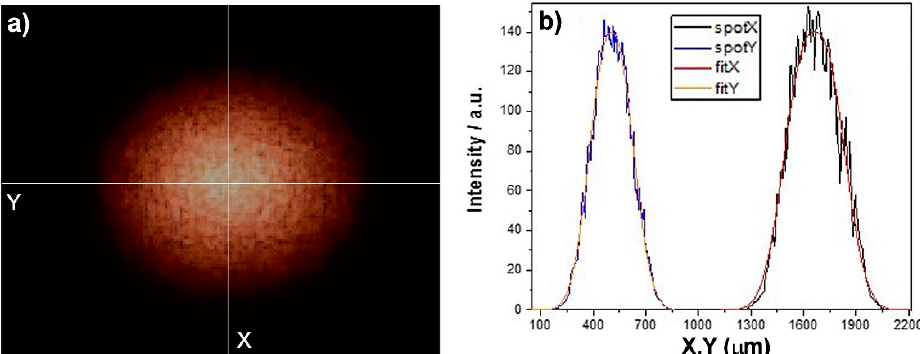
Figure 2. ( a ) Image of the focal spot of the laser excitation beam (500×). ( b ) Transverse (blue line) and longitudinal (black line) section of the focal spot and corresponding best fit (orange and red line) using super-Gaussian functions.